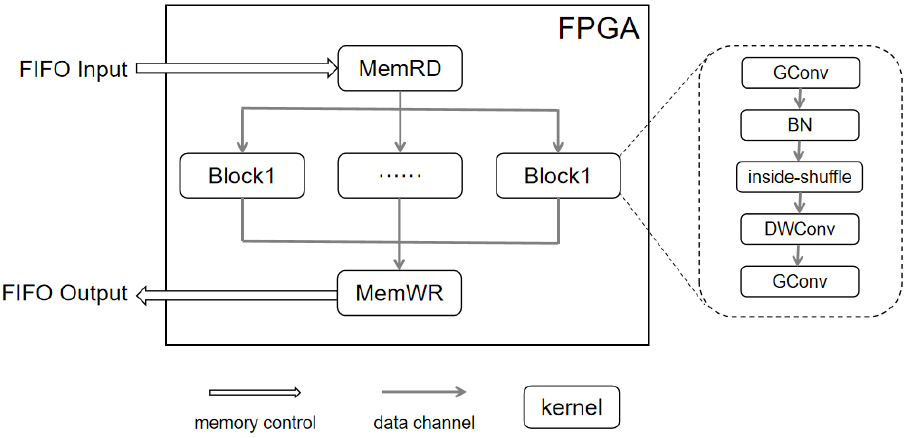
Figure 5. Proposed FPGA internal design.